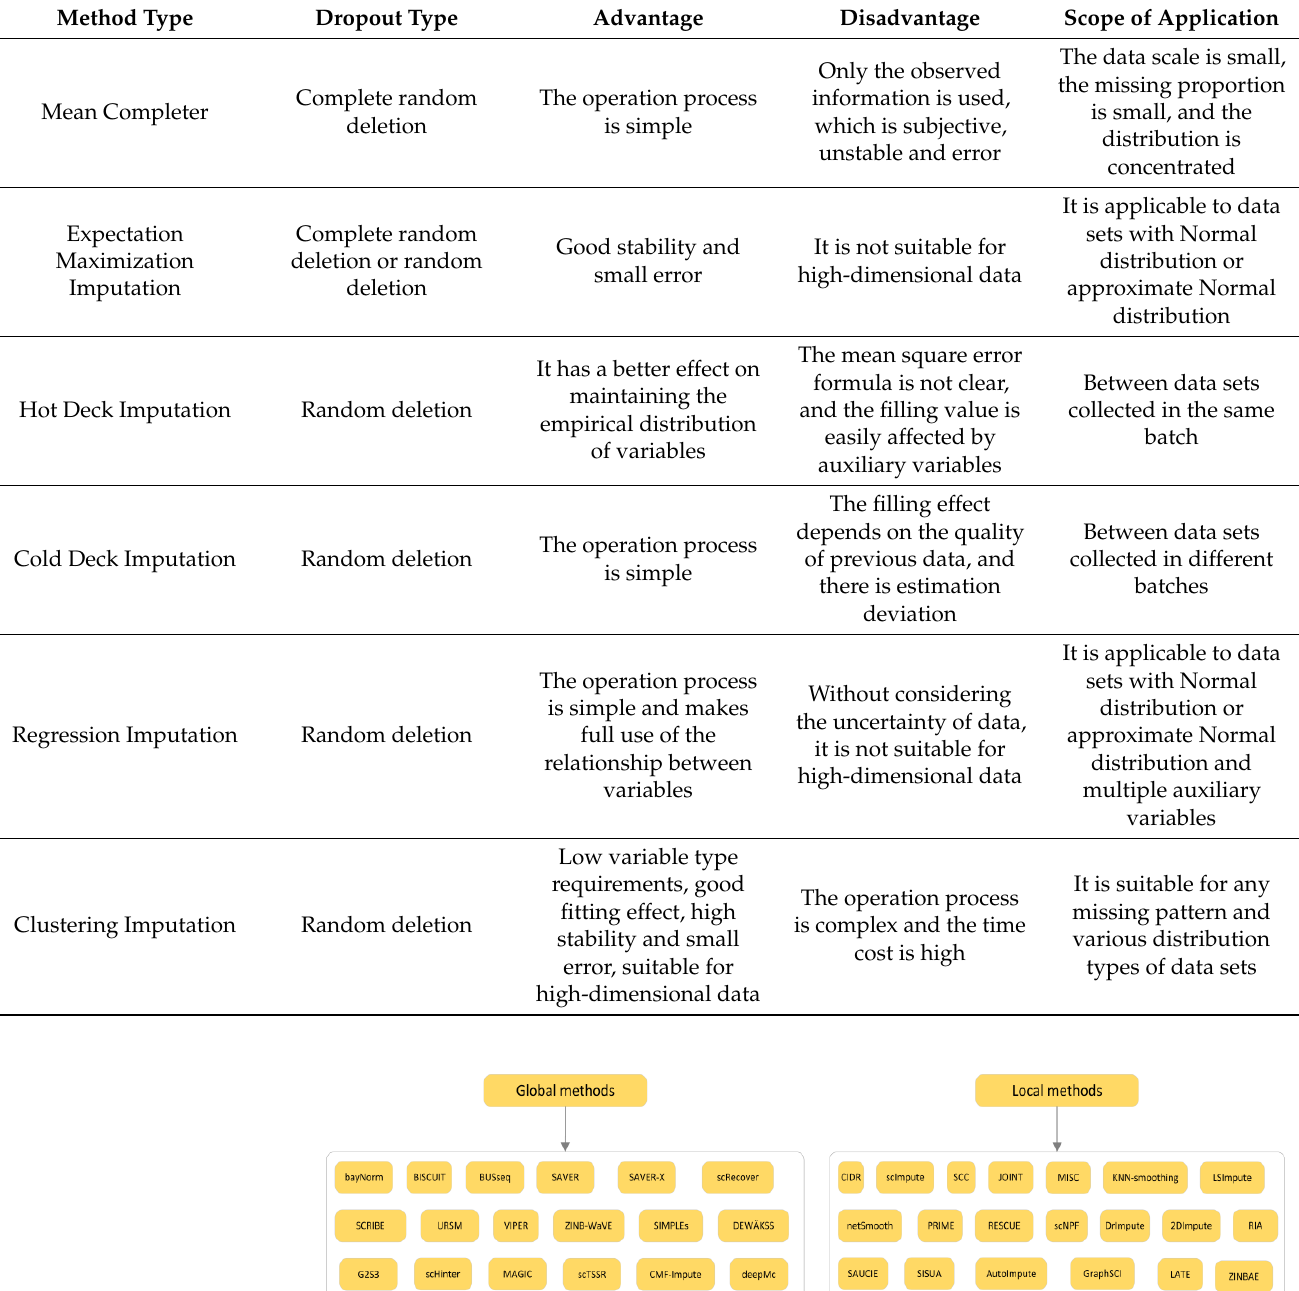
Table 1. Dropout types, advantage and disadvantages and scope of application of “dropout” values of statistical methods and machine learning methods.